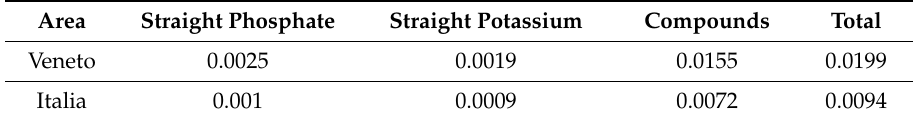
Table 3. Fertilizer density on Utilized Agricultural Area (UAA) in Veneto and in Italy (kg/m 2 ) in 2015. Area Straight